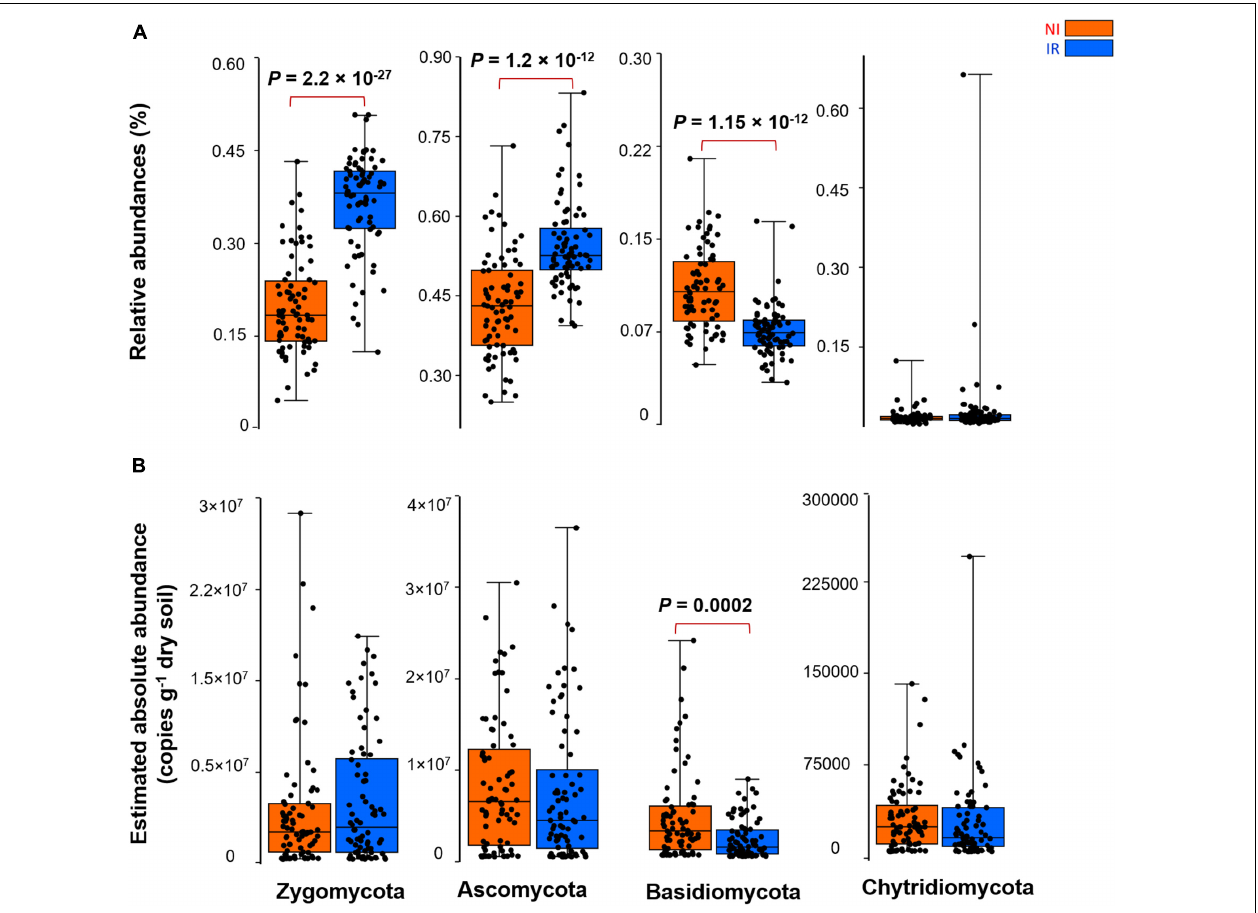
FIGURE 3 | The effect of soil history on (A) the relative and (B) estimated absolute abundance of different fungal phyla associated with the rhizosphere of four wheat genotypes grown in Saskatchewan soils with a water stress history (NI) or with no history of water stress (IR) exposed to four levels of soil water content. Dots are values for individual observations, the horizontal lines in boxes are representative of the median, the upper and lower part of boxes indicating 75th and 25th quartiles, and whiskers on the boxes showing 1.5 × the interquartile range. ANOVA tests comparing the abundance of each phylum between IR and NI